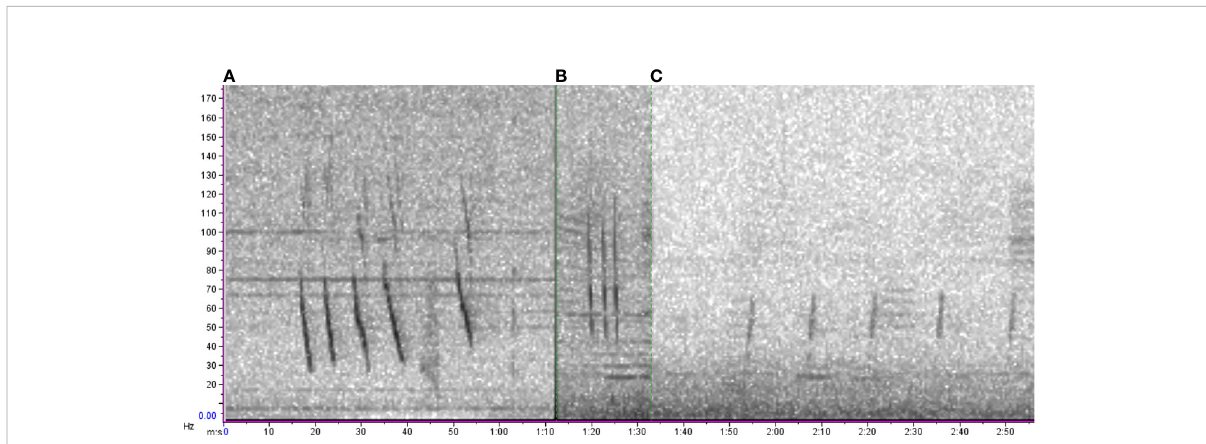
FIGURE 2 Spectrograms of (A) blue whale D-calls; (B) sei whale downsweep calls; (C) sei whale upsweep calls. Spectrogram parameters: FFT: 512 samples, 50% overlap, Hann